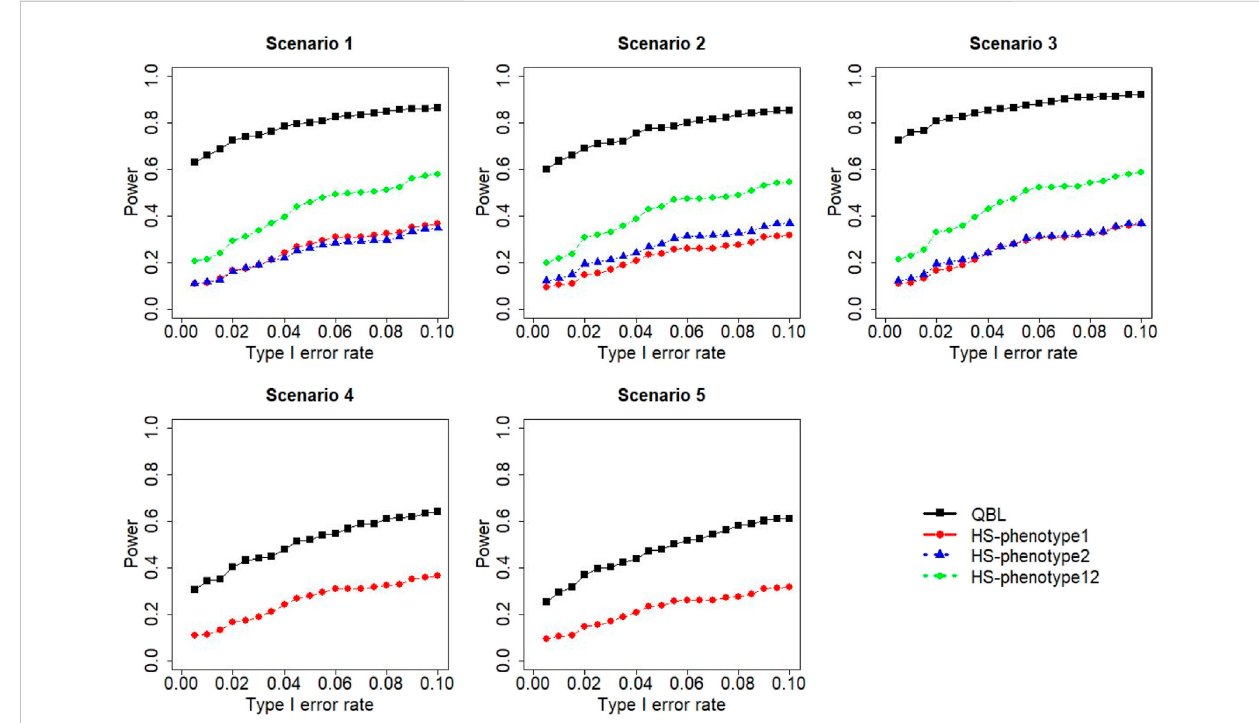
FIGURE 7 Simulation results under sample size 500, setting 2 (12 haplotypes), and ρ = 0.1. Scenarios are shown in Table 1. HS, Haplo.score; phenotype12, phenotype 1 or